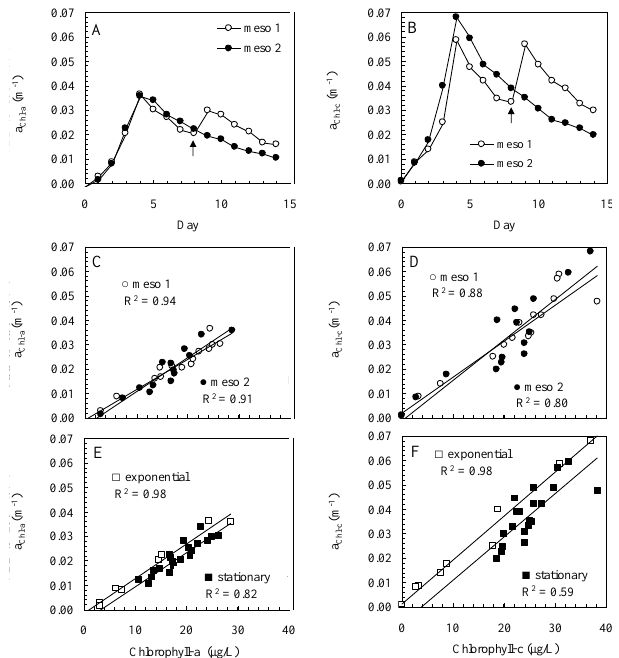
Figure 4. (a–f) Absorption characteristics in Phaeocystis . (a–b) Temporal development (days) of absorption by chlorophyll a ( a , a Chl a ,m − 1 ) and c ( b , a Chl c ,m − 1 ) calculated from reflectance spectra in both mesocosms. (c–f) Linear regression of absorption on chlorophyll a and c (m − 1 ) against Chl a and Chl c concentra- tions (µgL − 1 ) was performed separately for both mesocosms (c, d) and for exponential and stationary growth phases (e, f) .